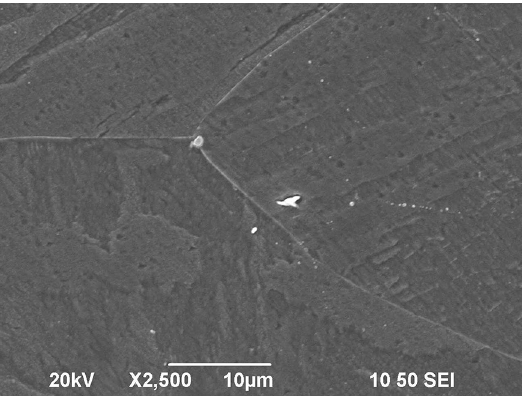
Figure 7. SEM image of solution heat treated specimen. The EDS analysis (Table 4) show that white precipitate is enriched in Mo and Ti (Vilella etch).